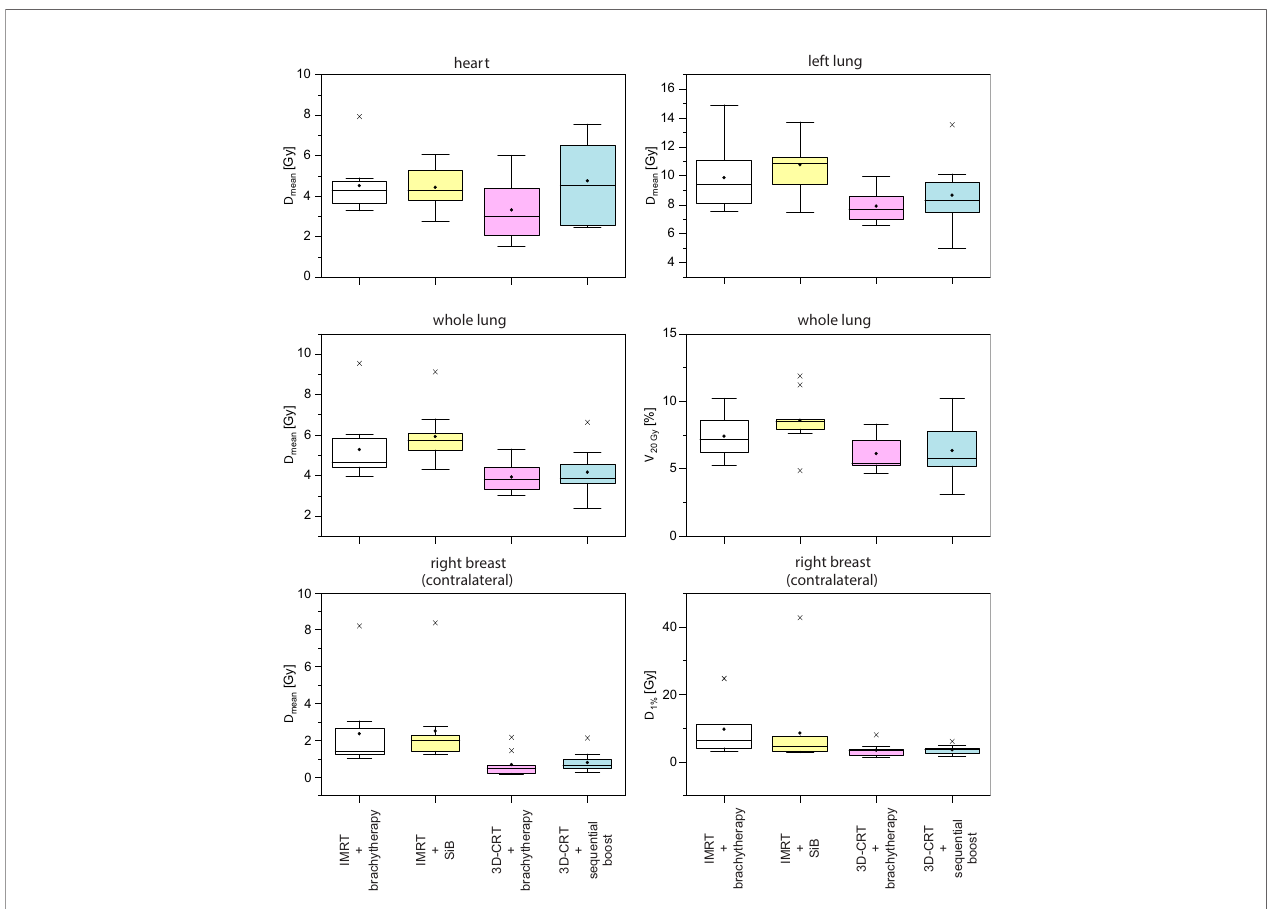
FIGURE 6 | Corresponding boxplots of the data and objectives given in Table 1